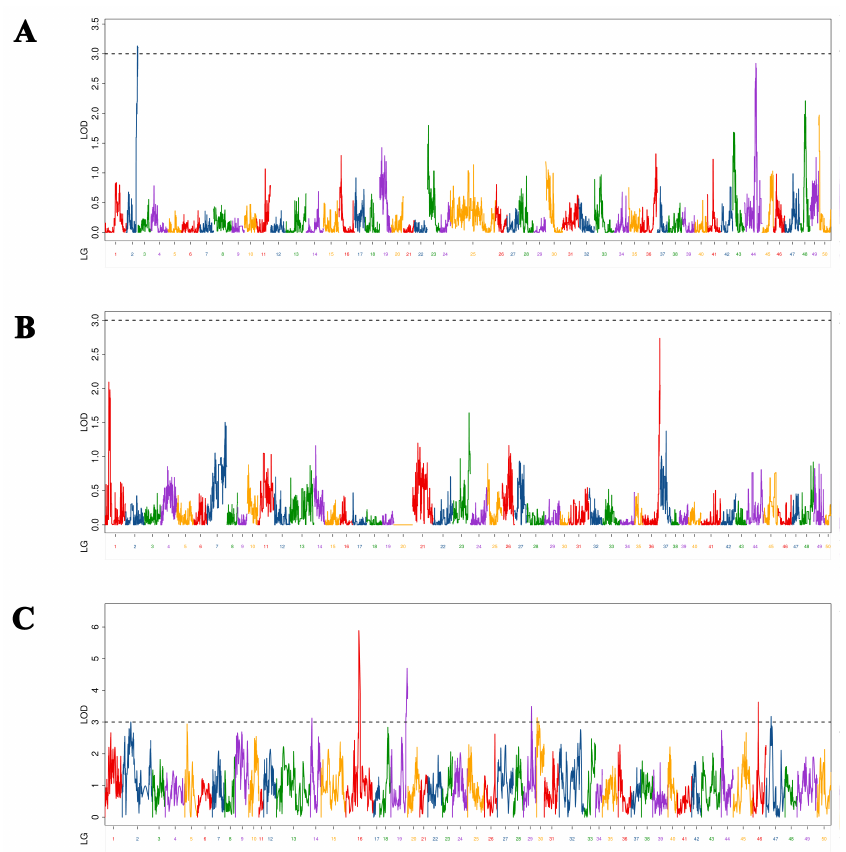
Figure 2. Distribution of body height-related QTLs on 50 linkage groups of Yellow River carp in the maternal ( A ), paternal ( B ), and HH maps ( C ). Different color indicates different linkage group.